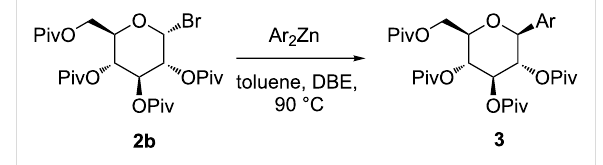
Scheme 1: Stereoselective synthesis of C -aryl glycoside by